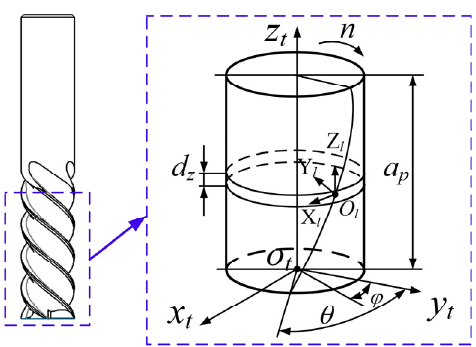
Figure 4. A typical end mill containing helical flutes.